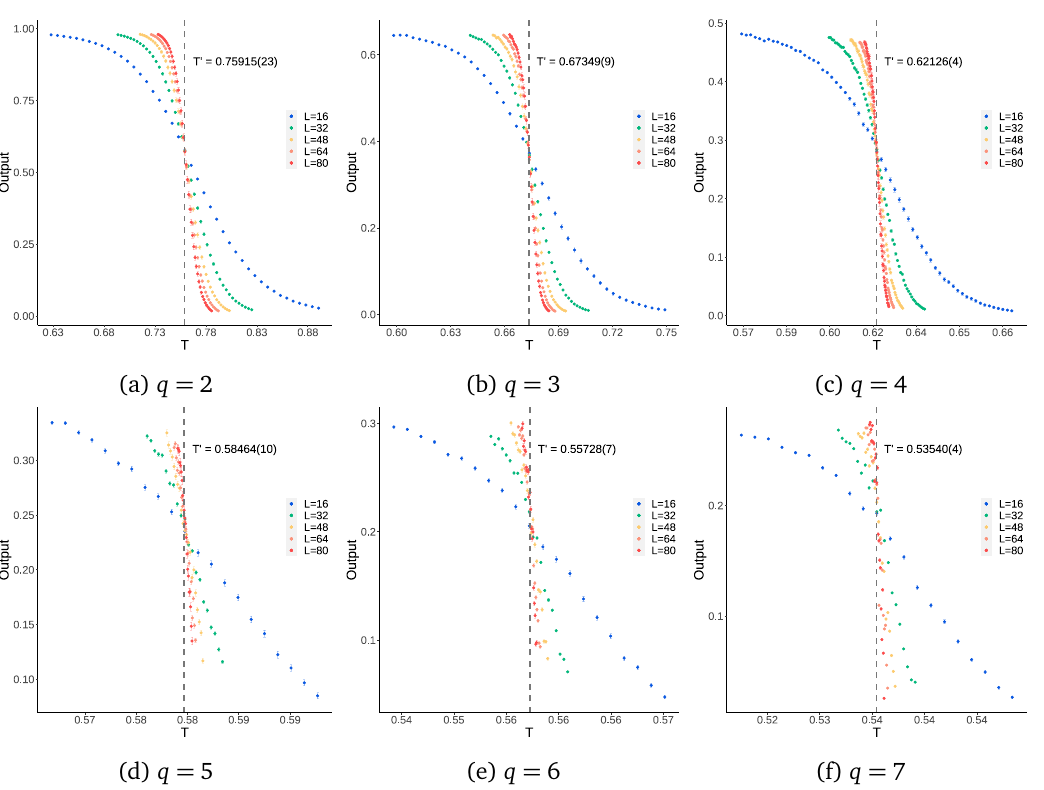
Figure 8: The relationship between temperature and the average output of an ensem- ble of 10 independently trained ANNs – training with MC data of the ferromagnetic square-lattice Ising model, and testing with MC data of the ferromagnetic q -state Potts model on a honeycomb lattice. The error bars shown are 99.7% confidence intervals of the ensemble average.